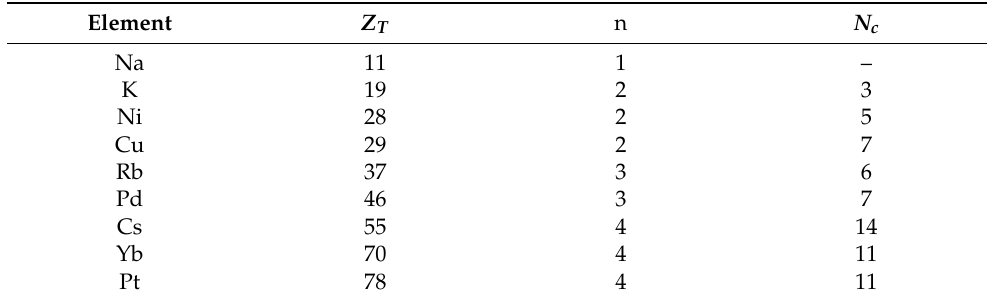
Table 9. Compilation of the features of the metal atoms, alkali atoms [13], and Yb [19], providing the charge Z T , number n of shells (without K -shell and outermost shell), and number N c of the deep DCS minima for which the corresponding spin asymmetry | S | ≥